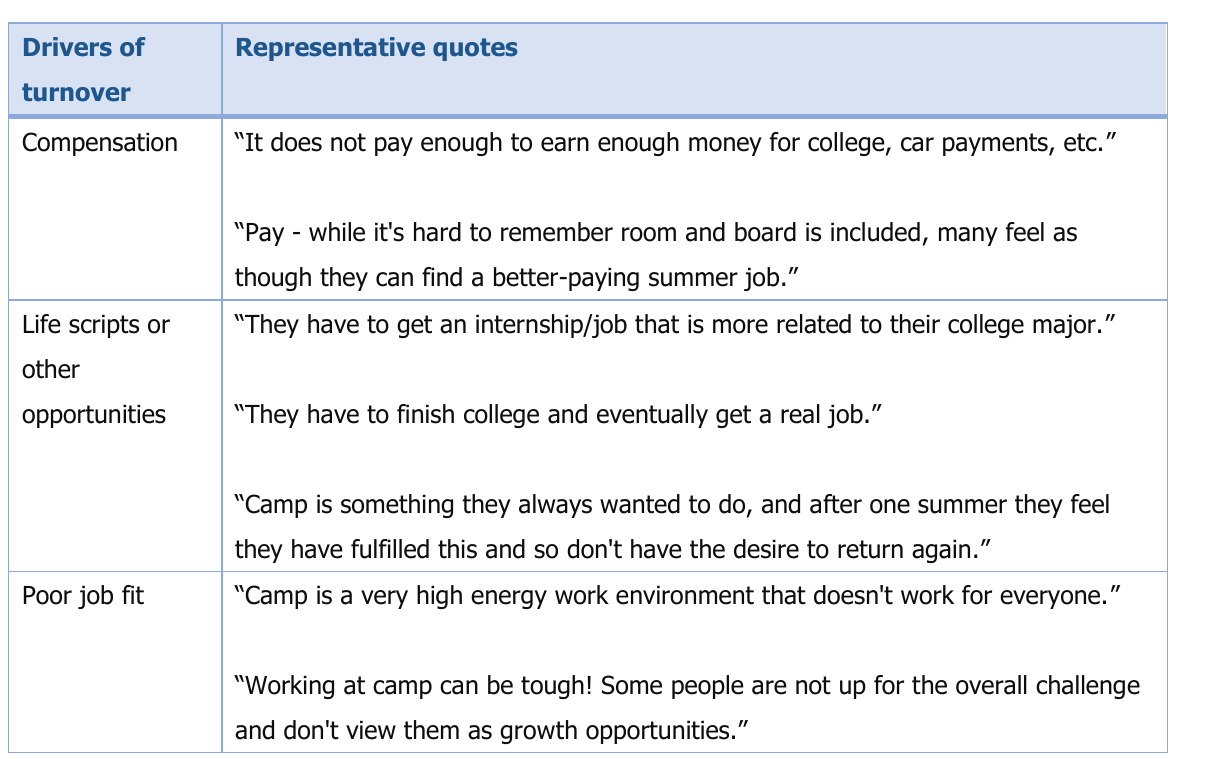
Table 7. Barriers to